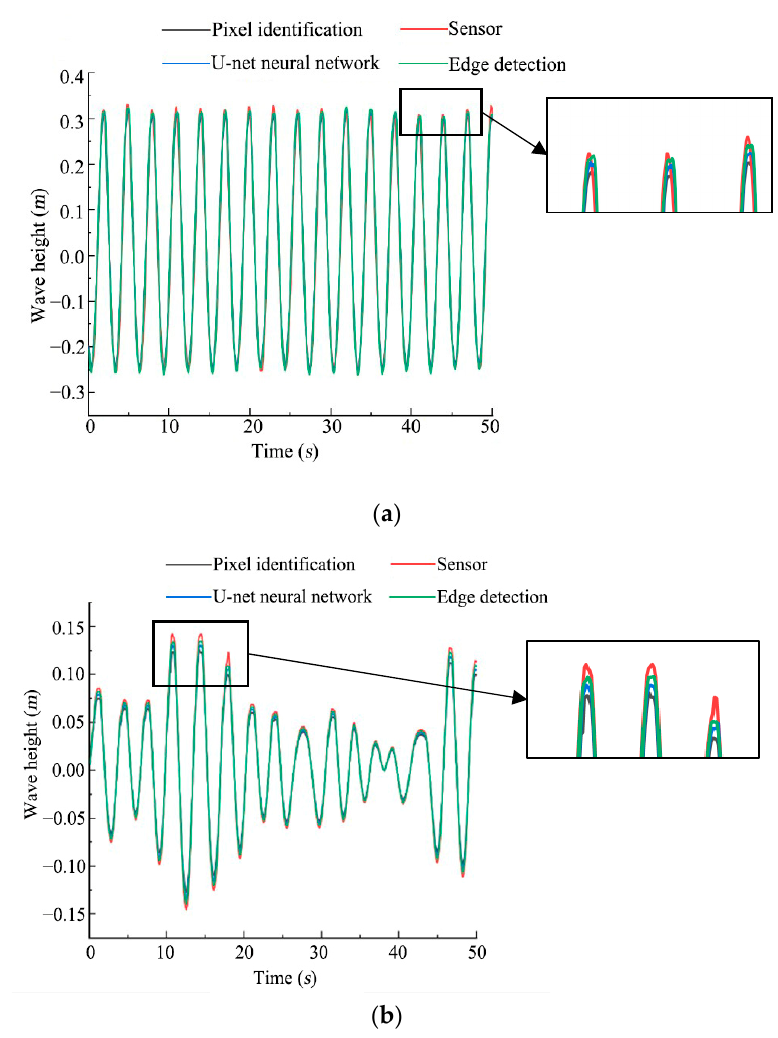
Figure 7. Comparison of waveform curves measured using four methods. ( a ) Group 6, ( b ) Group 9. To quantitatively calculate the errors of data measured by different methods, this study used relative errors as the measurement index of the experimental results, and the calculation method is shown in Equation (8).